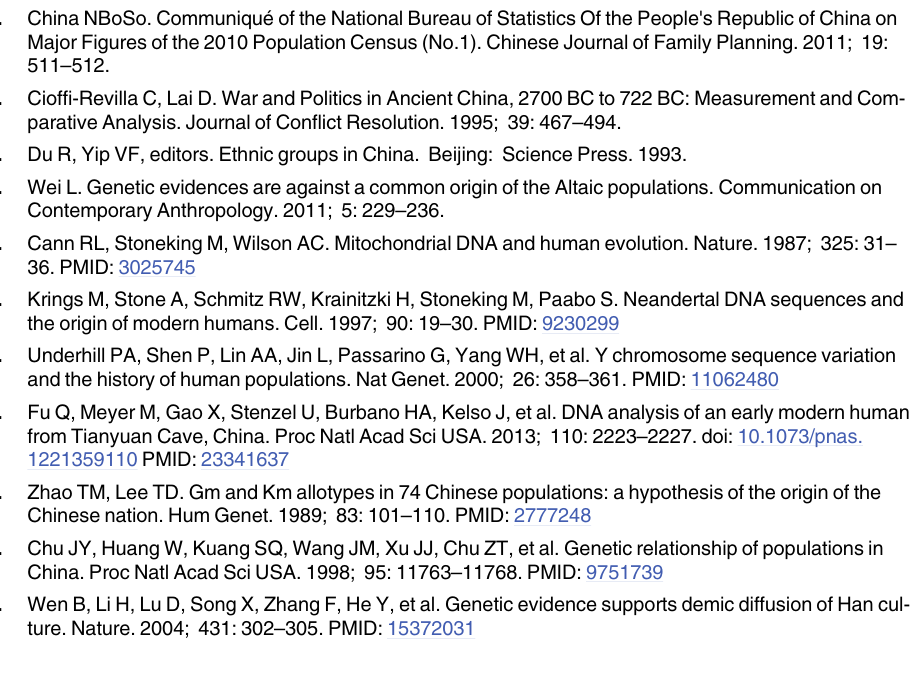
S2 Table. Primers used in this study. S3 Table. Estimated percentages of mtDNA haplogroups shared among ancient popula- tions and modern Chinese populations as well as the genetic diversity of each population. S4 Table. Estimated percentages of Y chromosome haplogroups shared among HB and modern Chinese populations. values and F p values between ancient and current S5 Table. Population pairwise F ST ST